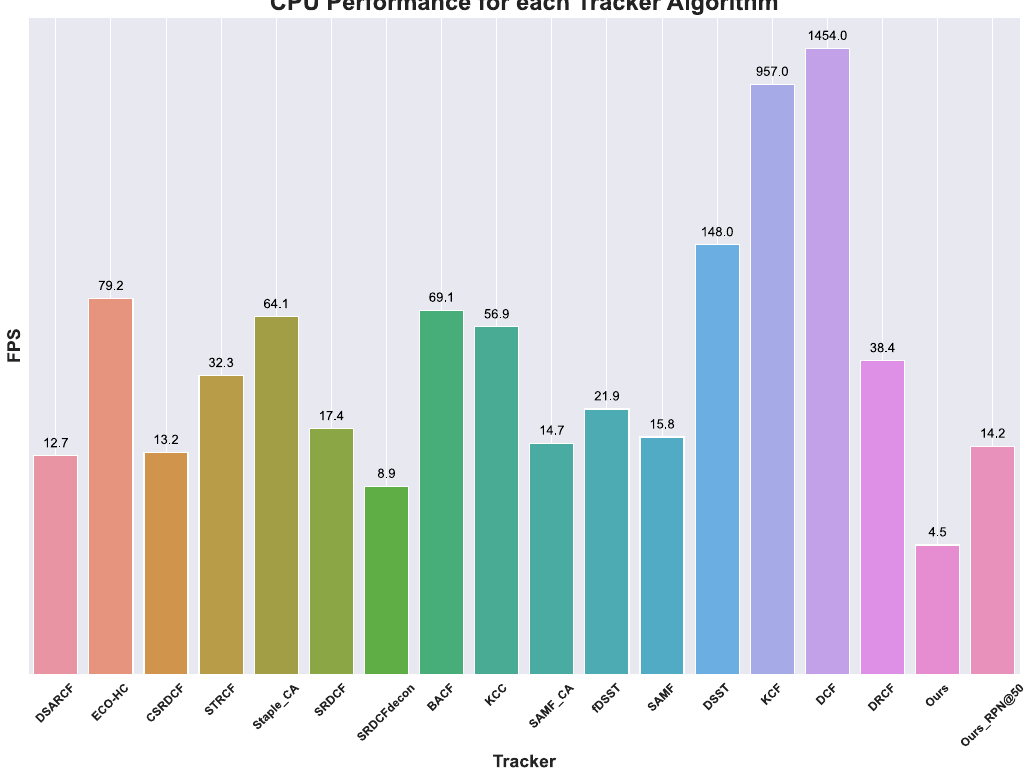
Figure 9. FPS obtained with each tracker on UAVDT dataset. On top of each bar, the FPS for the corresponding tracker is reported. To provide a visually correct data, the latter has been log-scaled before